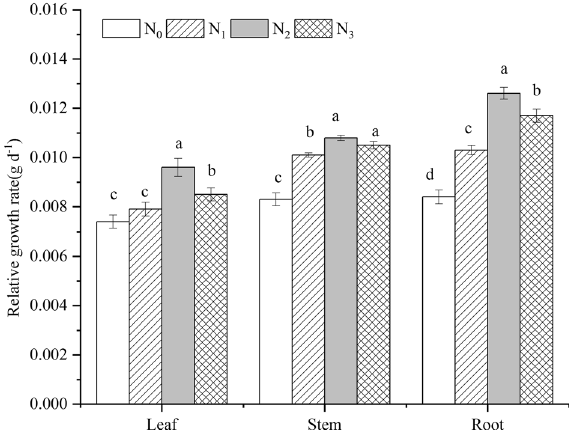
Figure 1. Effects of N addition on the relative growth rate of R. soongorica . Error bars represent SE (n = 6). Different lowercase letters above bars indicate significant differences at P < 0.05.